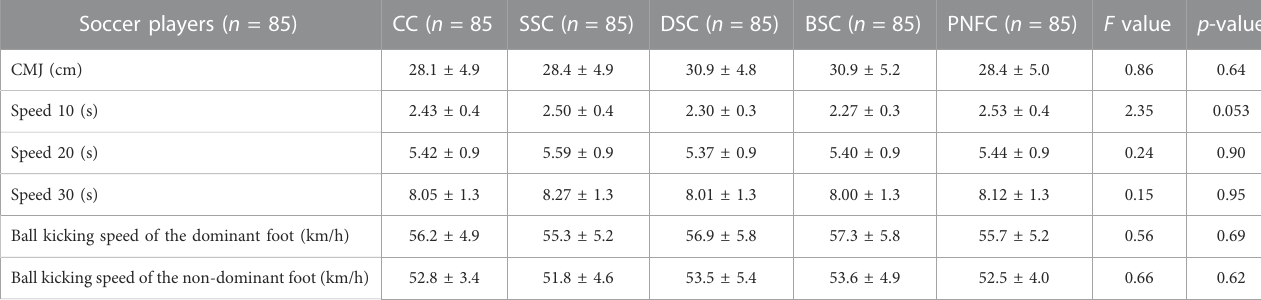
TABLE 1 Physical-speci fi c performance of youth ’ s male soccer players according to warm-up conditions. Soccer players ( n =